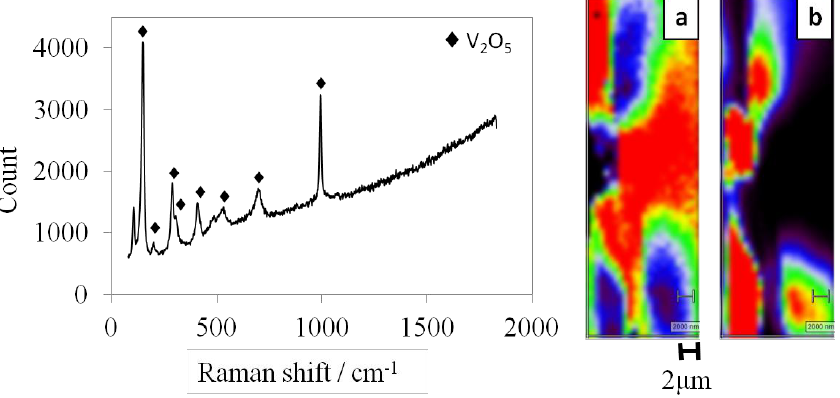
Figure 7. Raman spectroscopy of SMn-V SMn-V O of ( a ) V O ; and ( b ) the fluorescence area. 2 5 2 5